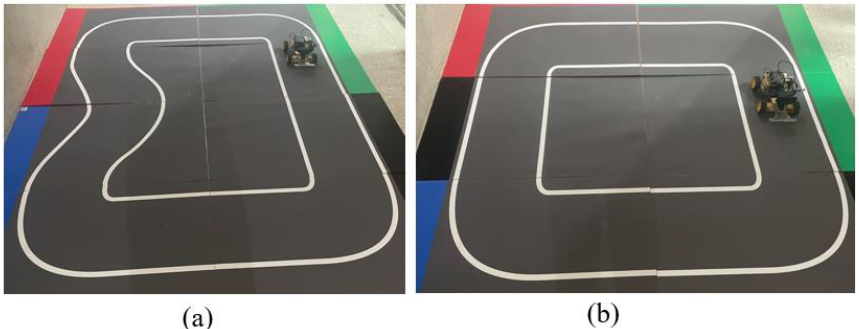
Figure 3. Vehicle test tracks, ( a ) Track A, a closed ellipse track with an S-shaped curve, and ( b ) Track B, a closed ellipse track.